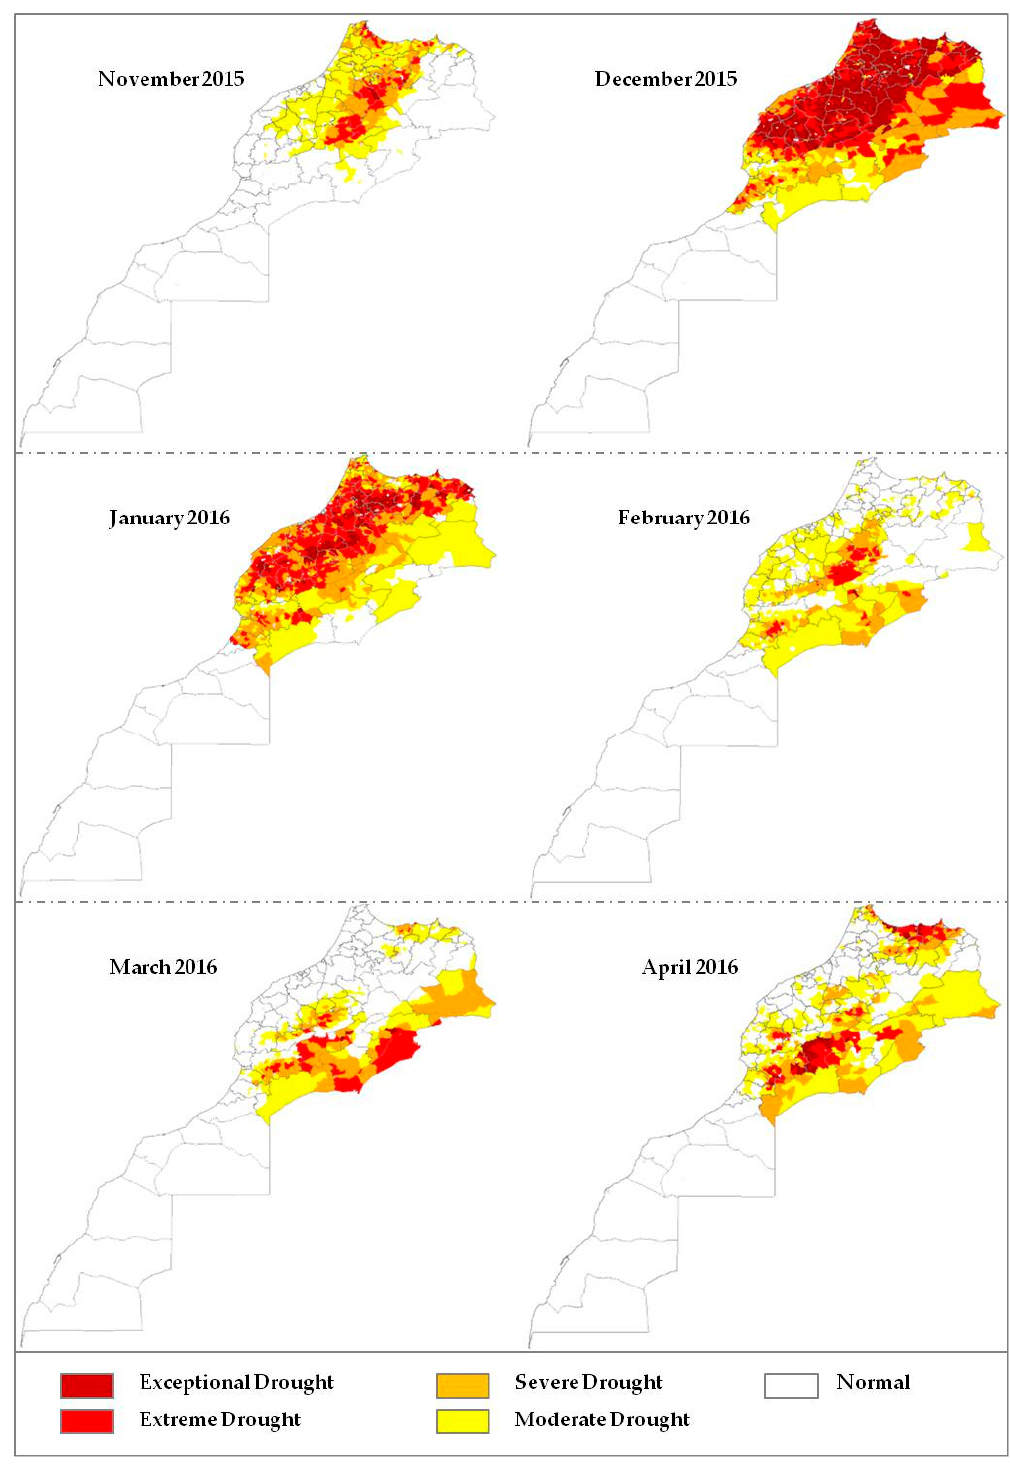
Figure 7. Composite drought indicator (October 2015 to April 2016).